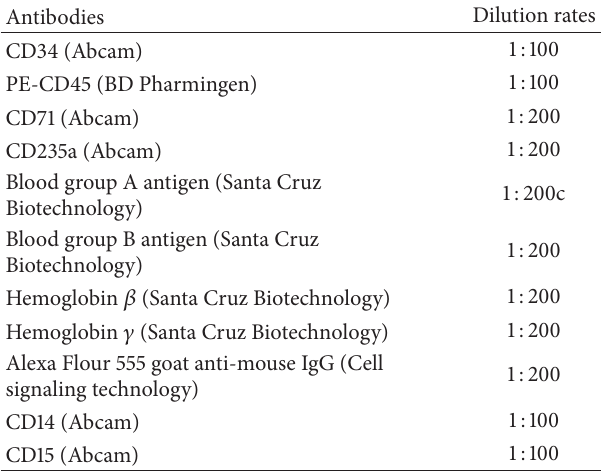
Table 2: Optimal dilutions of antibodies used for immunofluores-